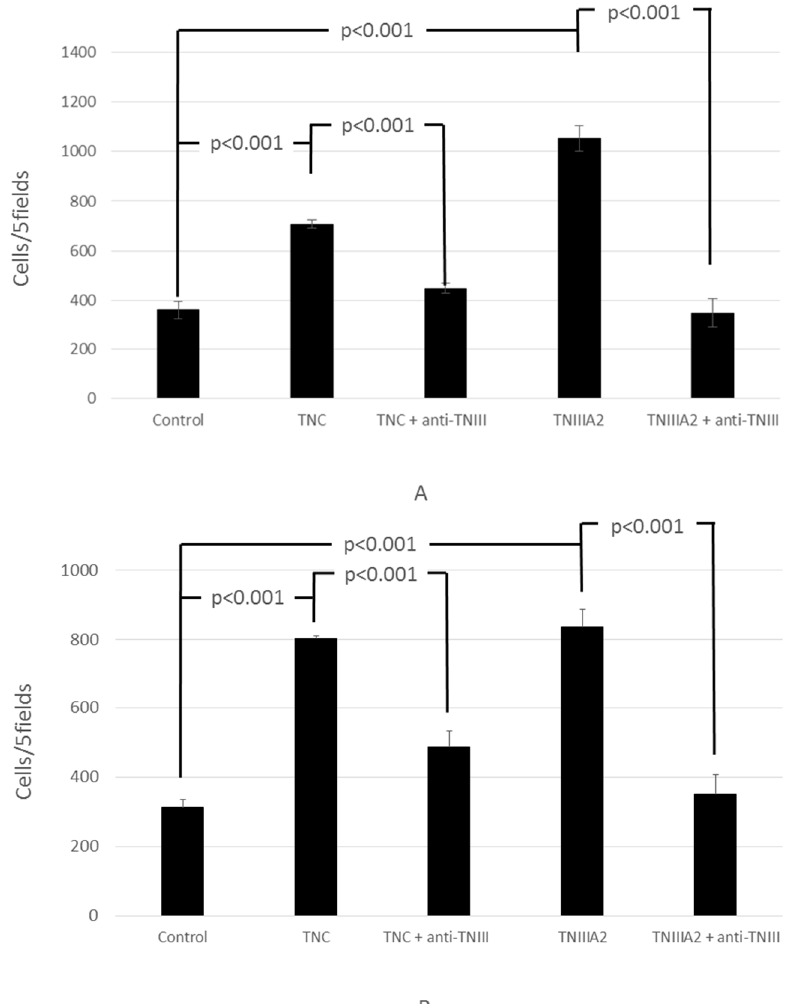
Figure 4. Involvement of anti-TNIIIA2 inhibitor in the increase of Colon26-M3.1 ( A ) or PMF-Ko14 ( B ) invasion by TNC and TNIIIA2. Colon26-M3.1 cells (3.0 × 10 4 cells/200 µ L/well) or PMF-Ko14 cells (3.0 × 10 4 cells/100 µ L/well) were seeded onto the upper compartment of the invasion chamber with TNC (10 µ g/mL) or TNIIIA2 (12.5 µ g/mL) and an anti-TNIIIA2 antibody (10 µ g/mL) and were allowed to invade for 24 h. Cells that invaded the lower surface of the membranes were stained with crystal violet and counted for four high-powered fields. Data represent the mean of three determinations ± SD.